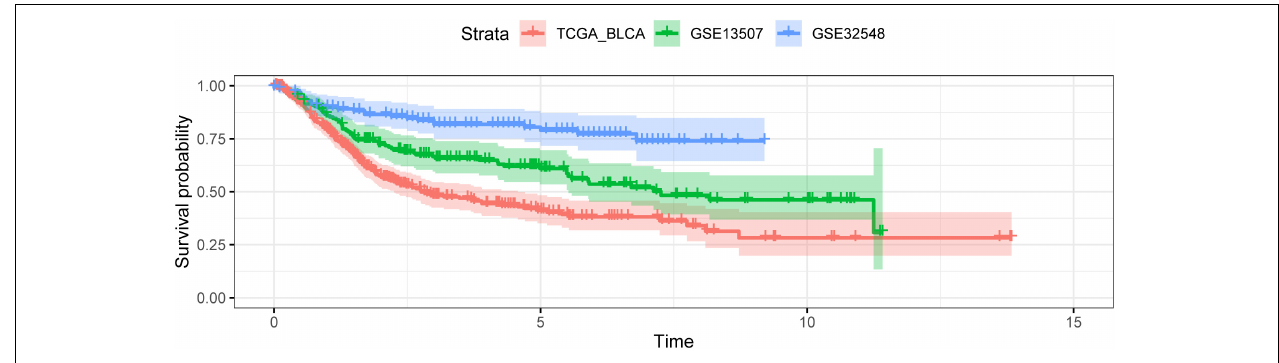
FIGURE 2 | The outcome variables of three datasets presented with the Kaplan–Meier curve. The survival outcomes of patients in three cohorts were